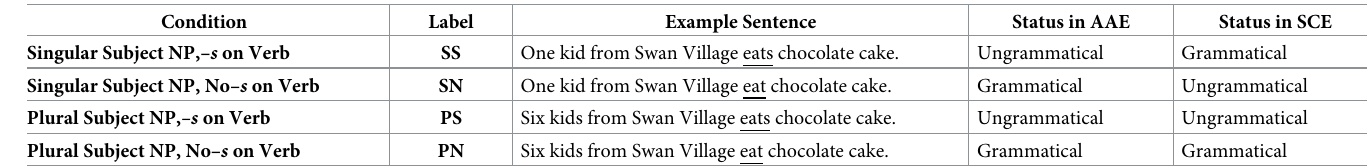
Table 1. Example stimuli for the four experimental conditions tested in the auditory ERP experiment and their grammatical statuses in AAE and SCE grammar. Condition Status in AAE Status in SCE